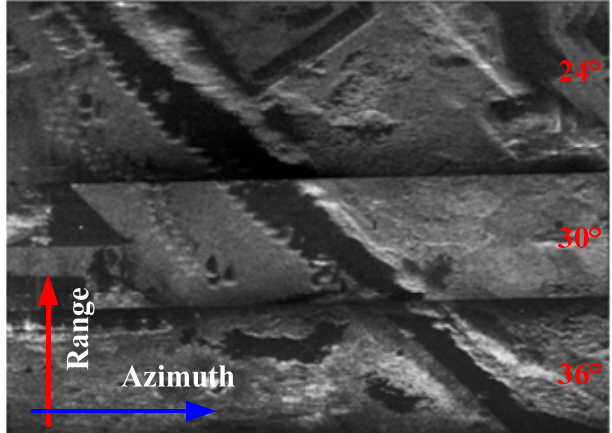
Figure 17. Image splicing in the range direction.